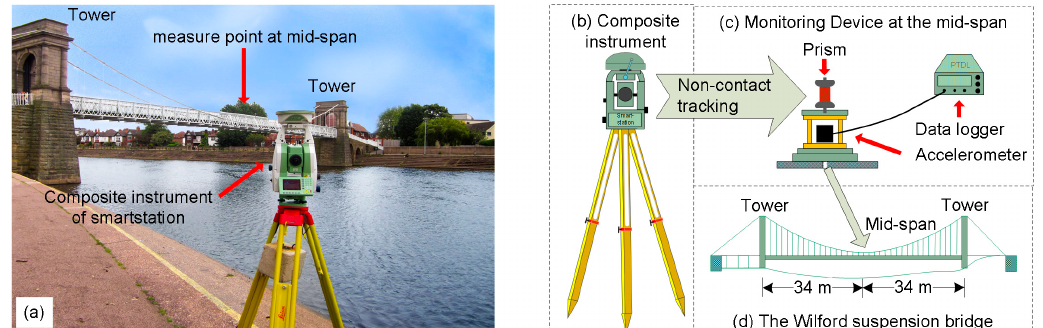
Figure 2. The Wilford Suspension Bridge in Nottingham and the instrumentation. The composite instrument was set near the bridge to monitor the structural dynamic response ( a ); the composite instrument ( b ) in non-contact mode locked and tracked a 360° prism that was installed outside a cage with a triaxial accelerometer, connected to a precise time data logger ( c ); the monitoring devices were fixed at the mid-span of the footbridge for dynamic response monitoring ( d ).